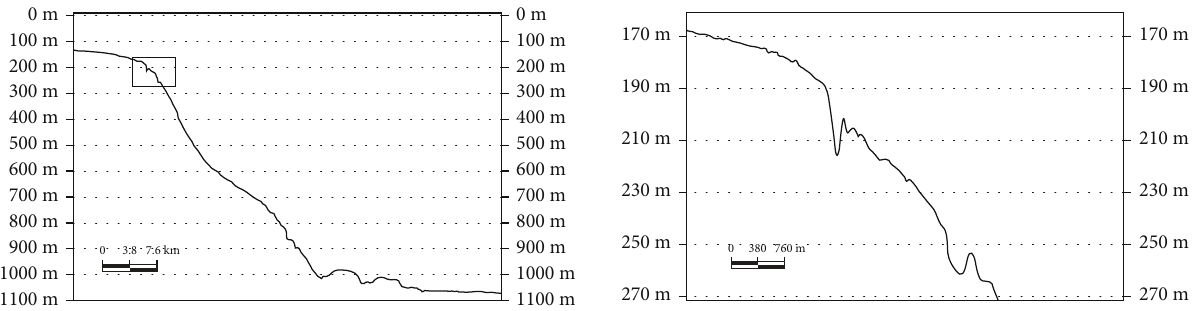
Figure 17: Topographic pro fi le of a typical land slope gully zone (the right fi gure is a partial enlargement fi gure of the box in the upper left corner of the left fi gure).